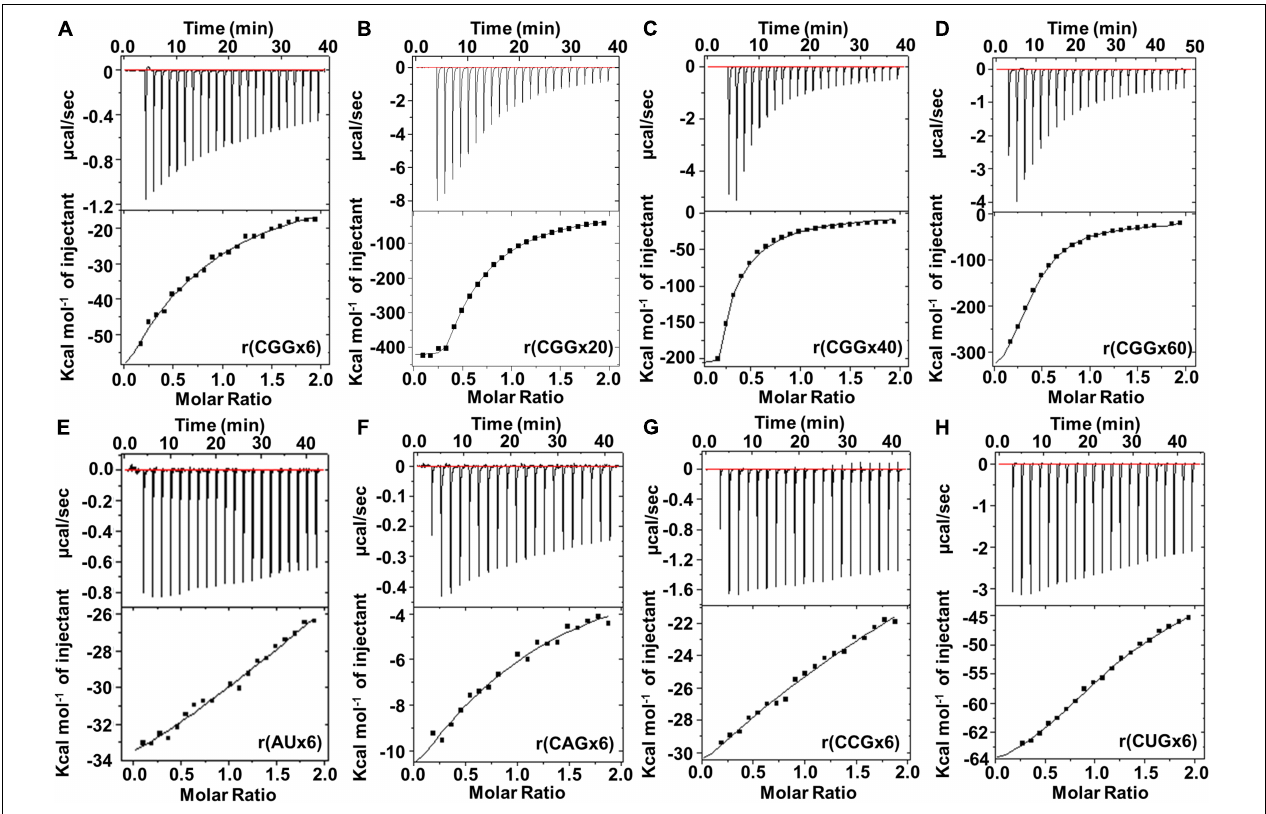
FIGURE 2 | Isothermal calorimetry titration of Curcumin with different mismatched and fully paired RNAs. (A) r(CGGx6), (B) r(CGGx20), (C) r(CGGx40), (D) r(CGGx60) and (E) r(AUx6), (F) r(CAGx6), (G) r(CCGx6), and (H) r(CUGx6) represents the thermogram of respective RNA with Curcumin. The exothermic peaks represent the favorable contribution of energy during interactions. Two-mode ligand binding saturation model was used to fit the plots.